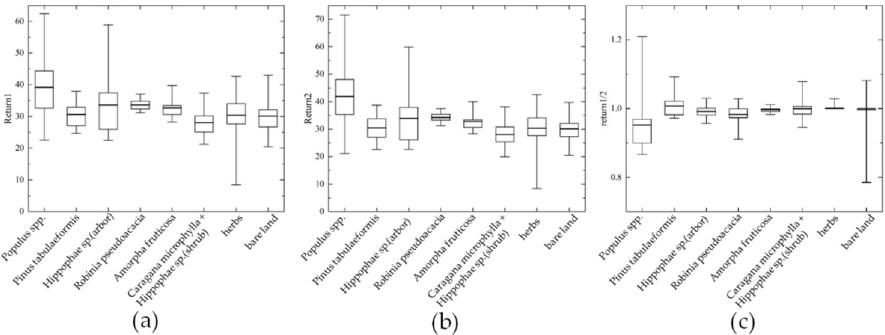
Figure 6. Echo distribution of eight types of vegetation species composition: ( a ) the first echo; ( b ) the second echo; ( c ) the ratio of the first echo to the second echo.